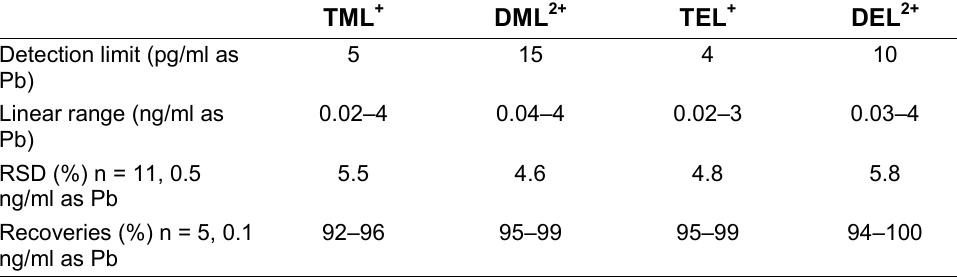
Analytical Characteristics for Speciation Analysis of Organolead Compounds in Rainwater Samples Using a C -DDC Derivative as Sorbent 60